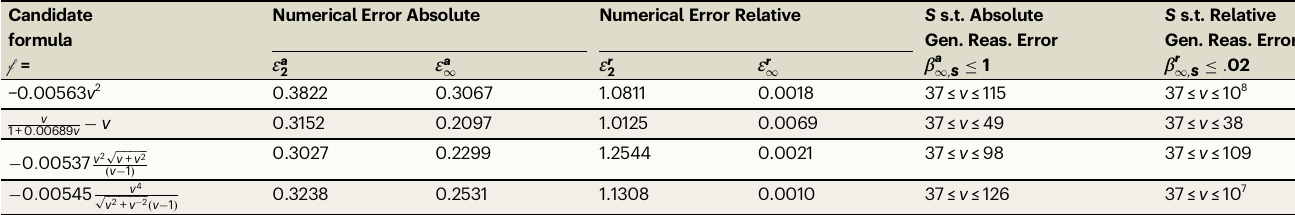
Table 2 | Candidate functions derived from time dilation data, and associated error values Candidate